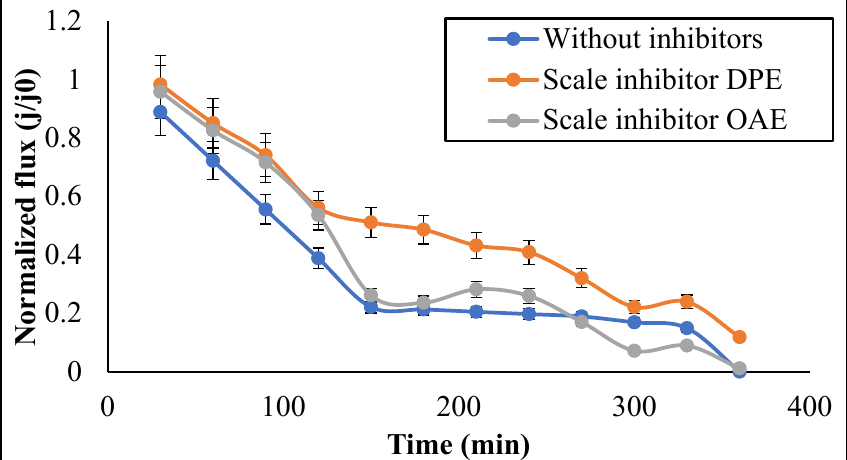
Figure 10. Permeate flux with time for TFCNF membrane without inhibitors, with scale inhibitor DPE, and with scale inhibitor OAE (Flow rate = 1 L/h, temperature = 35 ± 2 °C, pressure = 32 bar).